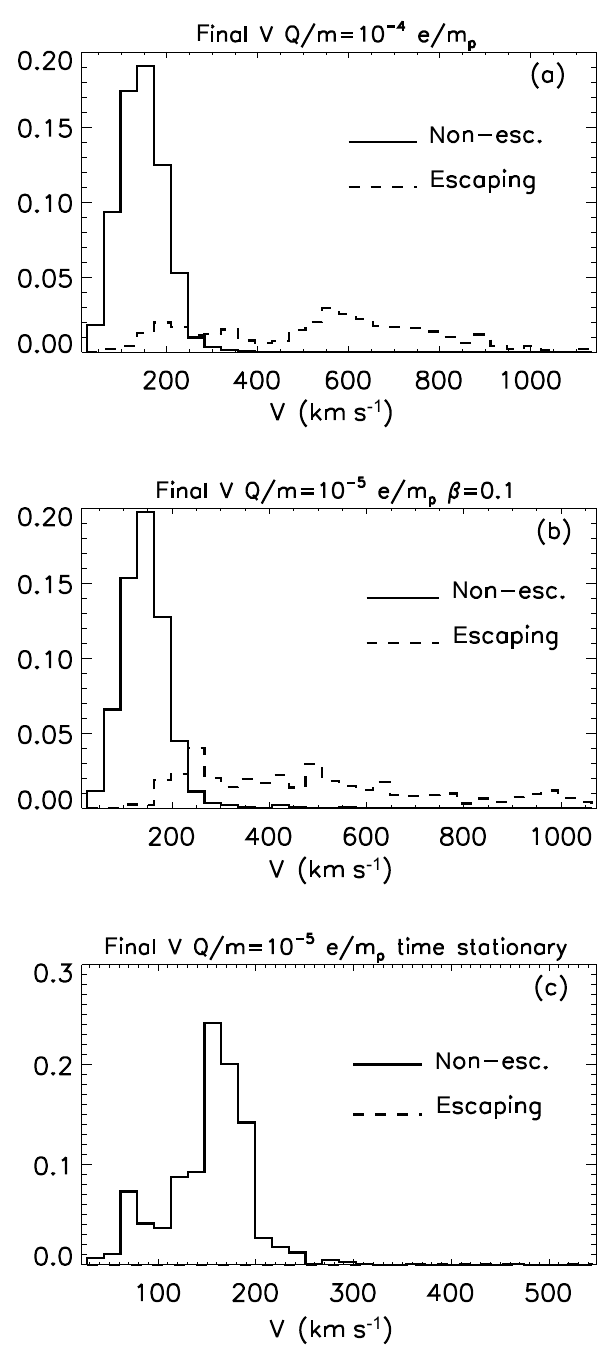
Figure 5. As Fig. 4 but for the following cases: (a) Q/m = 10 − 4 e/m p , (b) Q/m = 10 − 5 e/m p with gravity modified by the factor ( 1 − β) , β = 0 . 1, and (c) Q/m = 10 − 5 e/m p for the time- stationary plasma configuration (initial time frame of the CME so-